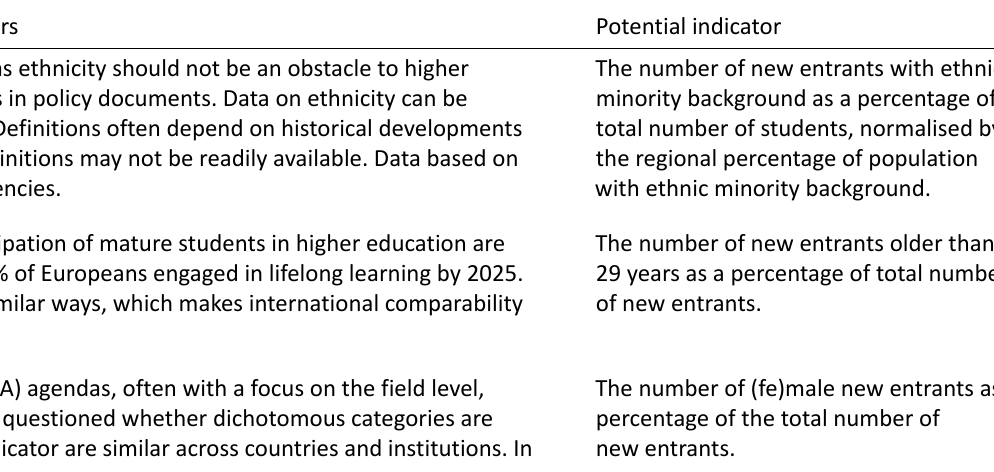
Table 2. (Cont.) Overview of underrepresented student groups and considerations for operationalisation, consolidated insights.